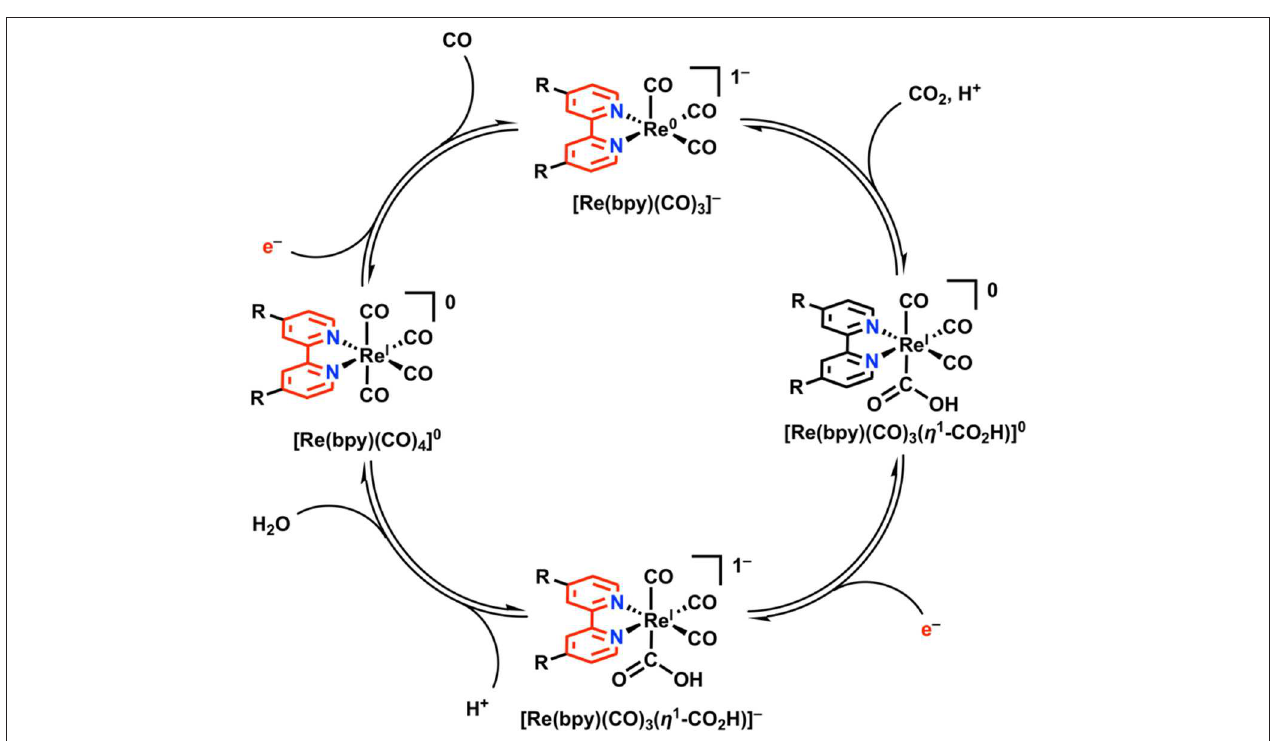
FIGURE 8 | 2e − /2H + -dependent catalytic cycle for Re(bpy)(CO) 3 X in the reduction of CO 2 to CO. Adapted with permission from Machan et al. (2014b). Copyright 2014 American Chemical